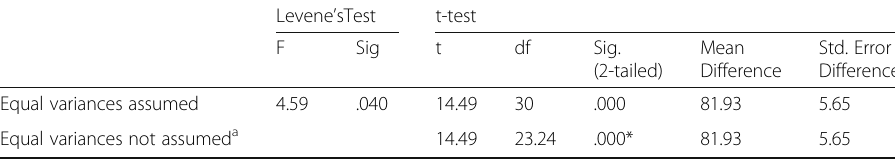
Table 5 Independent samples test between the MAWQ and writing proficiency Levene ’ sTest t-test Sig